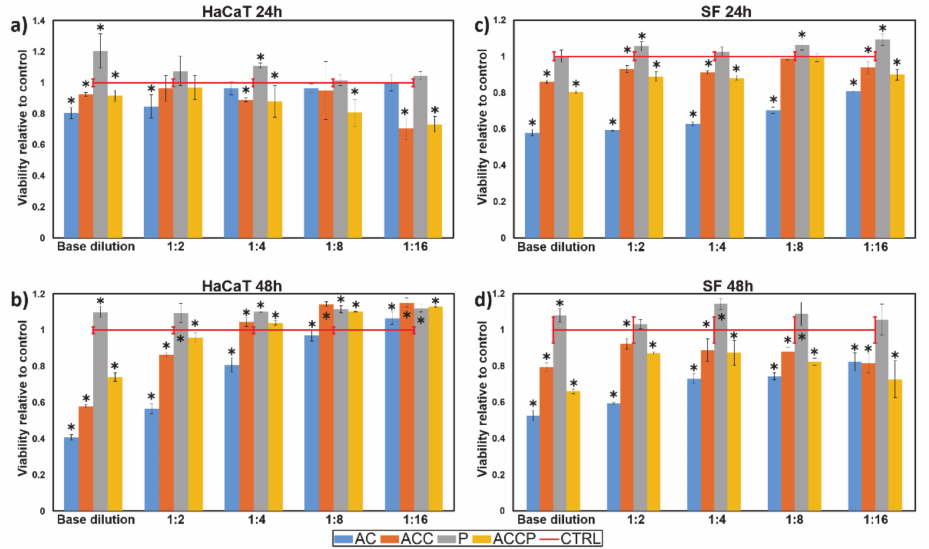
Figure 7. Results of the MTT biocompatibility assay for keratinocytes (HaCaTs) ( a , b ) and human skin-derived fibroblasts (SFs) ( c , d ) obtained after 24-h and 48-h incubation periods. The asterisks indicate where the differences between the sample and the control were statistically significant ( * p <